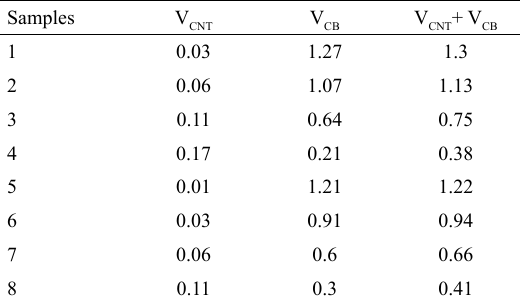
Table 1. Volumetric fraction (V) (%) of CNT and CB in the MCFFS